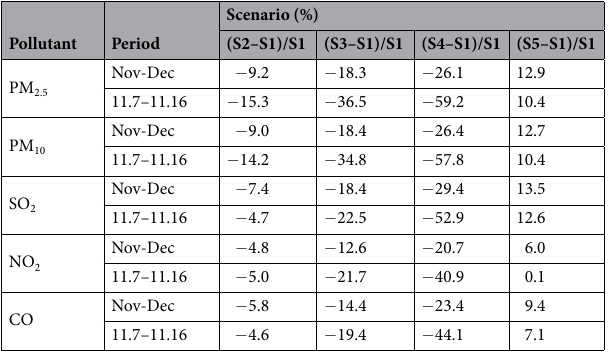
Table 2. Percentage changes in the pollutant concentrations among the different